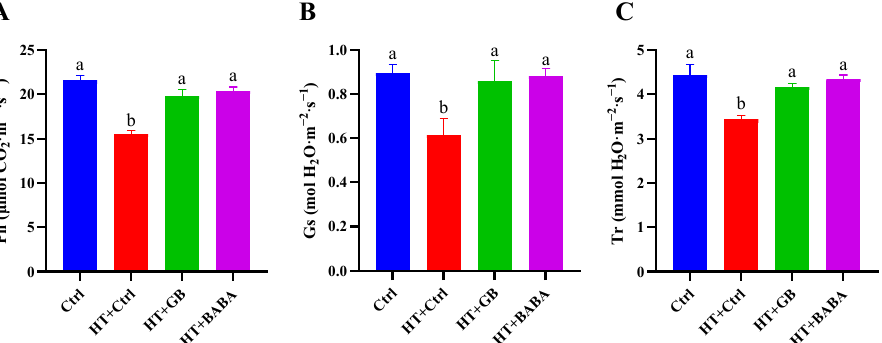
Figure 3. Effects of GB and BABA on gas exchange parameters in Chinese cabbage under heat stress: Pn ( A ), Gs ( B ), Tr ( C ). Data are shown as mean ± SD of five replicates. Different lowercase letters indicate significant difference at p < 0.05. Ctrl, optimum conditions; HT + Ctrl, HT + GB, and HT + BABA seedlings were foliar sprayed with water, GB, and BABA, respectively, before exposure to high temperature. Pn, net photosynthesis rate; Gs, stomatal conductance; Tr, transpiration rate.